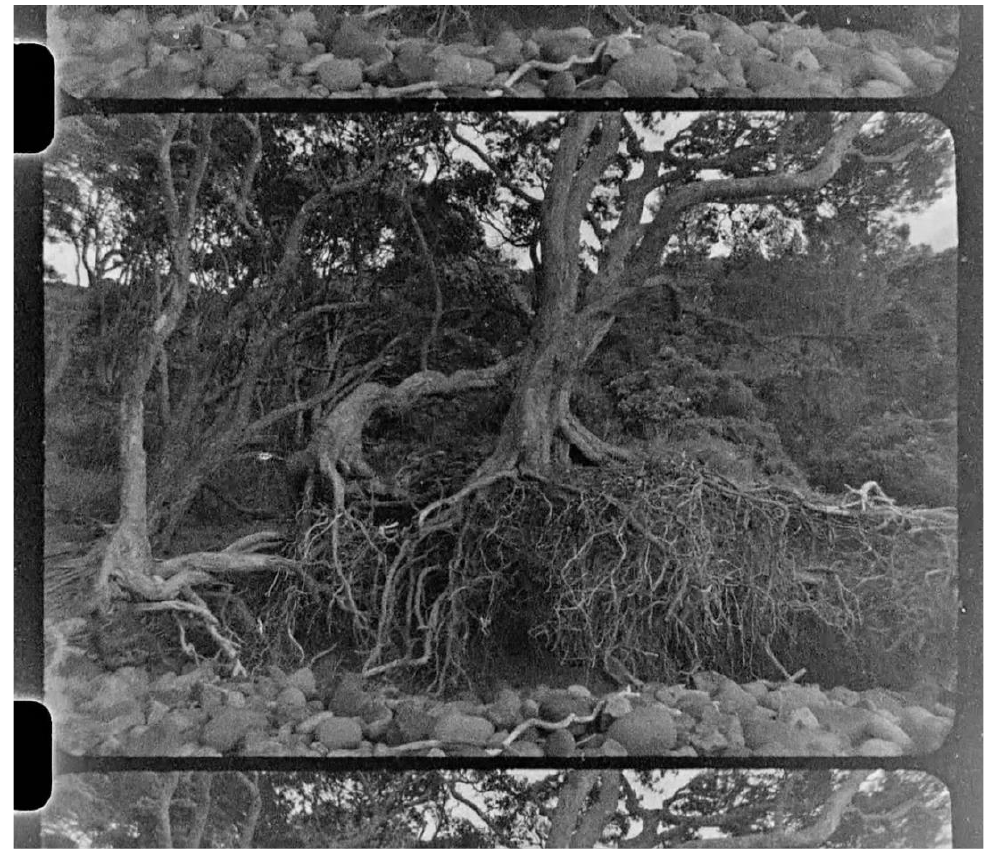
Figure 6. Nova Paul, Hawaiki , 2022, 16mm film print.